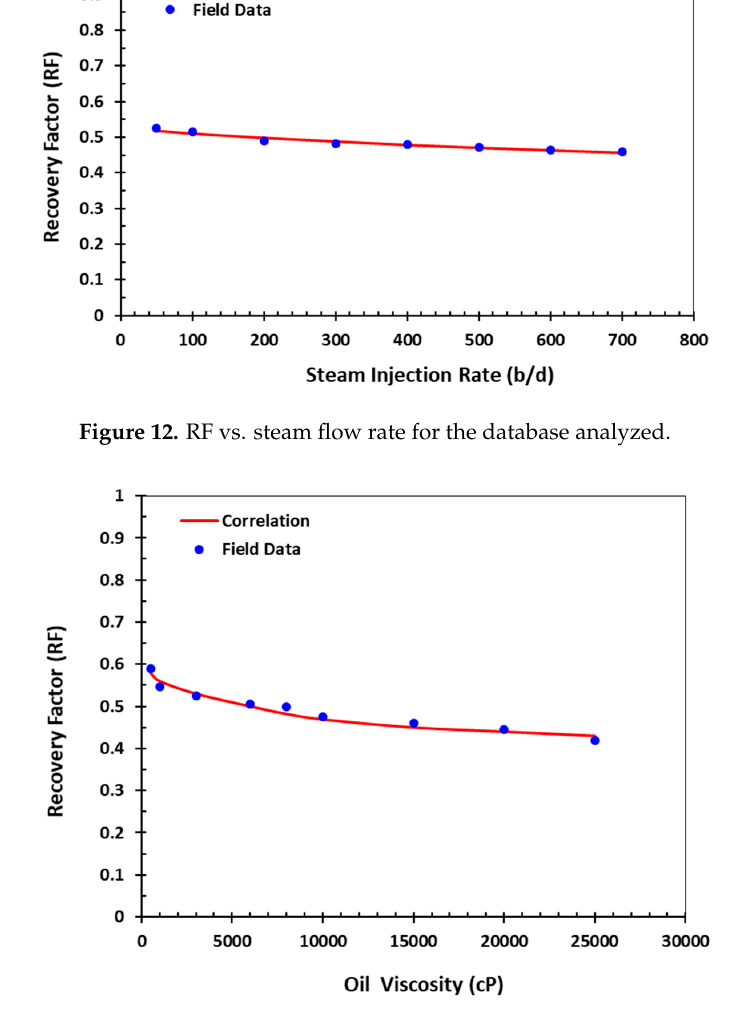
15 of 29 Figure 9. Residuals vs. porosity for the database analyzed.